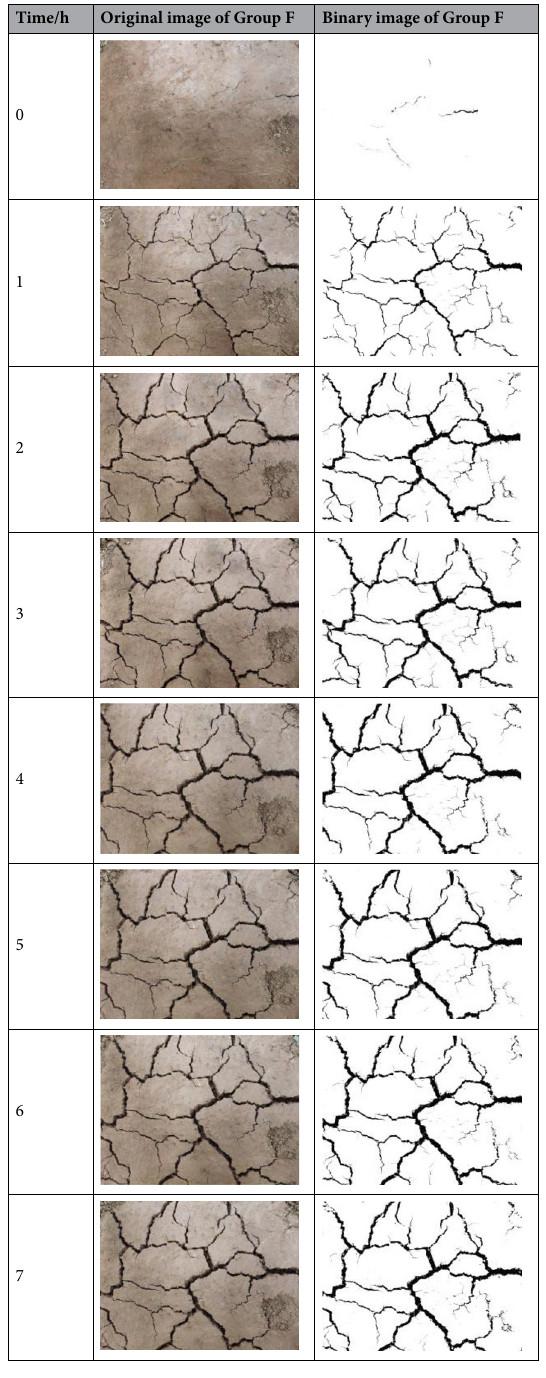
Table 3. Crack pictures of the first dry–wet